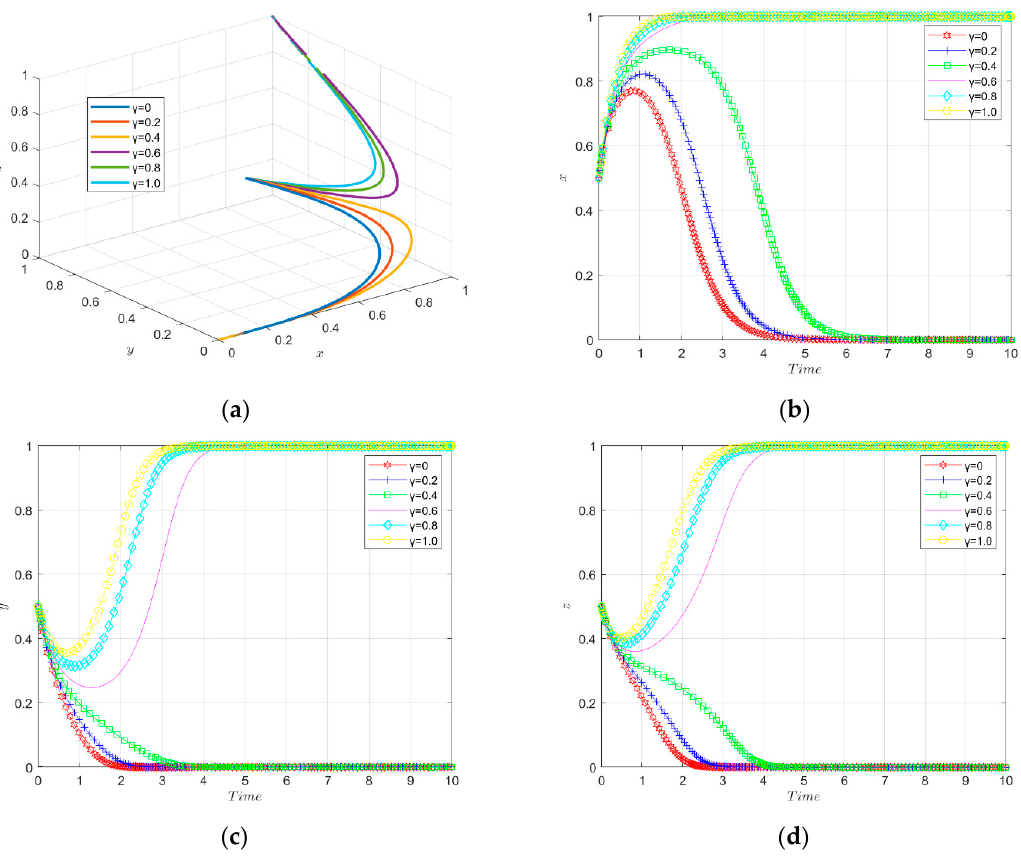
Figure 11. ( a ) Triadic evolutionary trajectory under γ changes. Evolutionary trajectories of enterprises ( b ), government ( c ) and financial institutions ( d ) under different penalties on enterprises enforcement intensities.